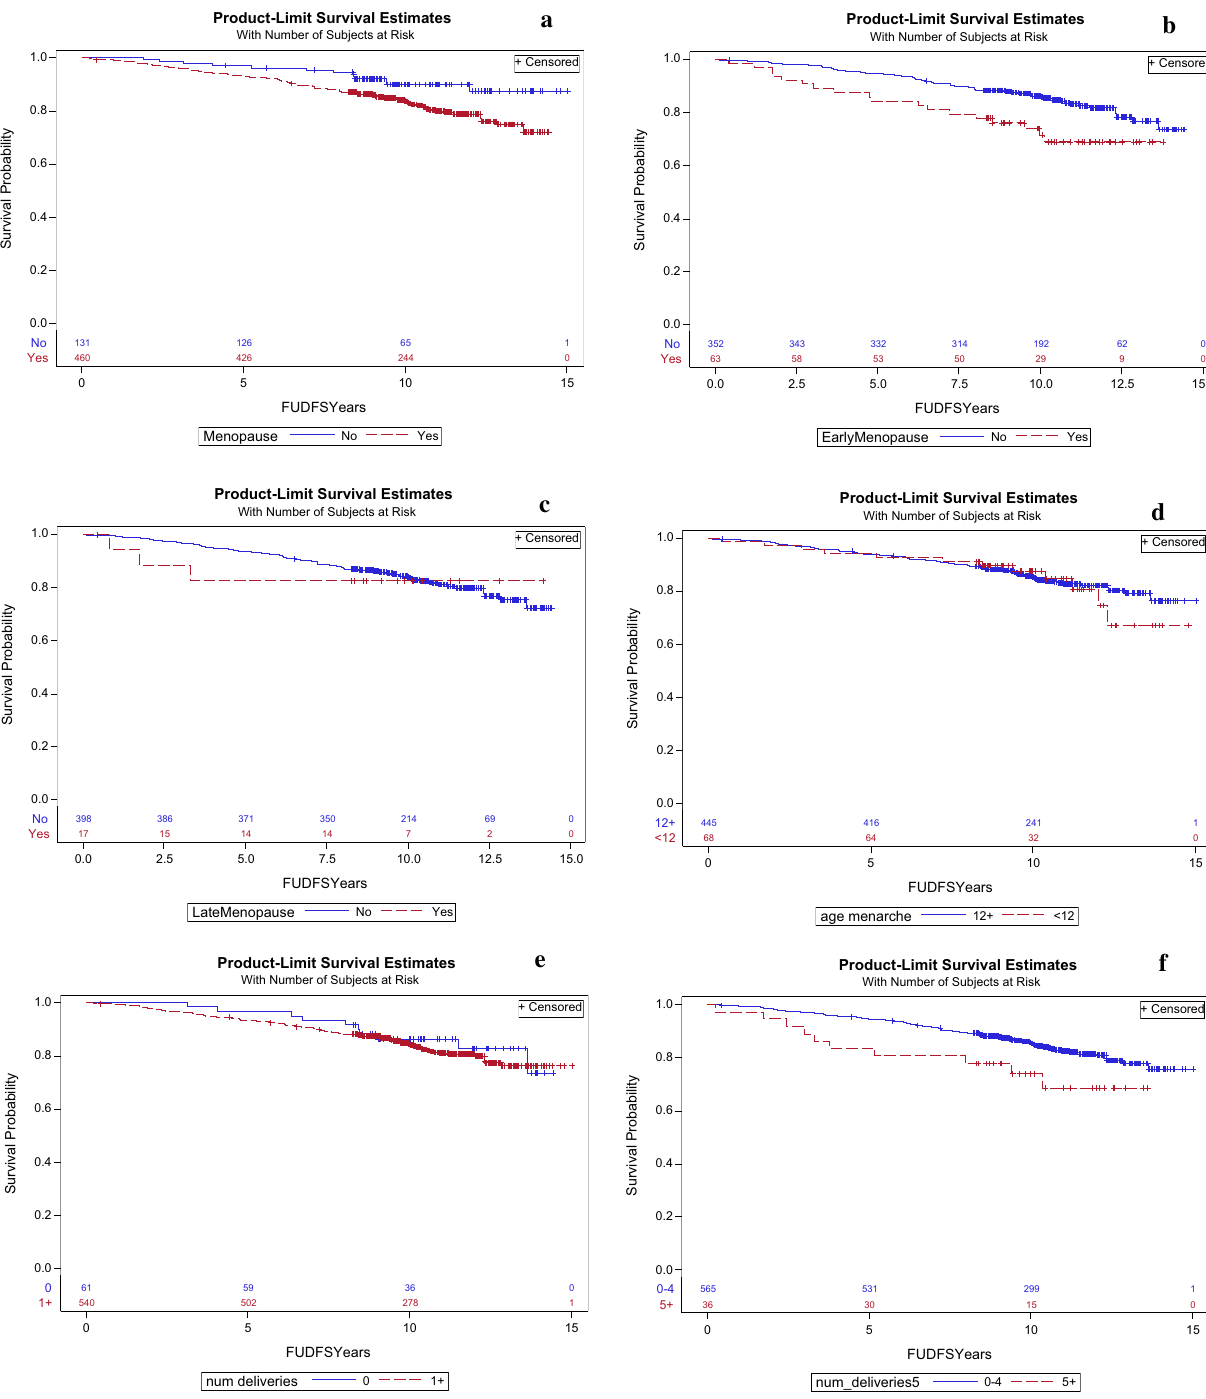
Fig. 1 Disease free survival probabilities in a menopausal women, b early menopause (menopause before the age of 45), c late menopause (menopause older the age of 55), d early age at menarche (menarch before the age of 12), e nullipara, f number of deliveries (0–4 vs. 5 and more), g age at first live birth (30 years and older vs. < 30